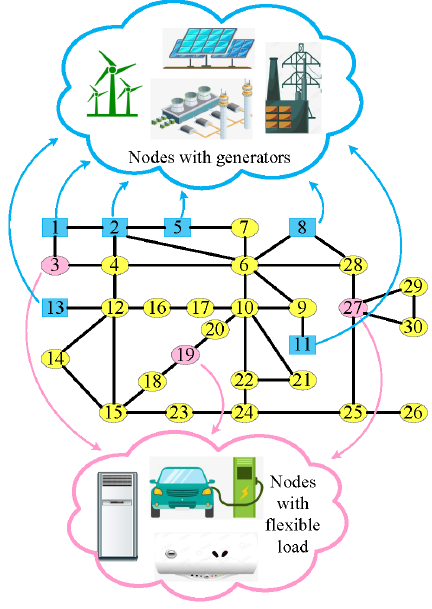
Figure 9. IEEE 30-bus system with EVs or flexible loads.